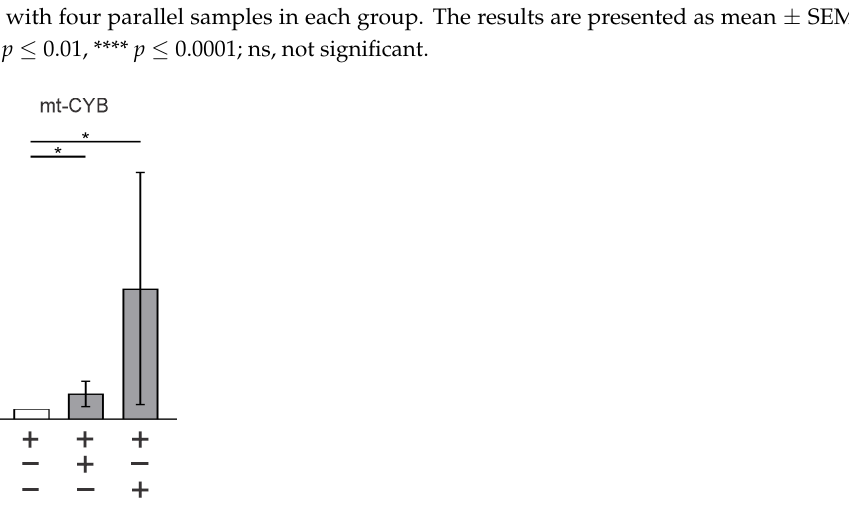
Figure 5. The expression of cytosolic mt-CYB in MG-132 or epoxomicin-treated ARPE-19 cells. Data were combined from four independent experiments, with at least two parallel samples in each group. The results are presented as mean ± SEM. The results are presented as mean ± SEM. * p ≤